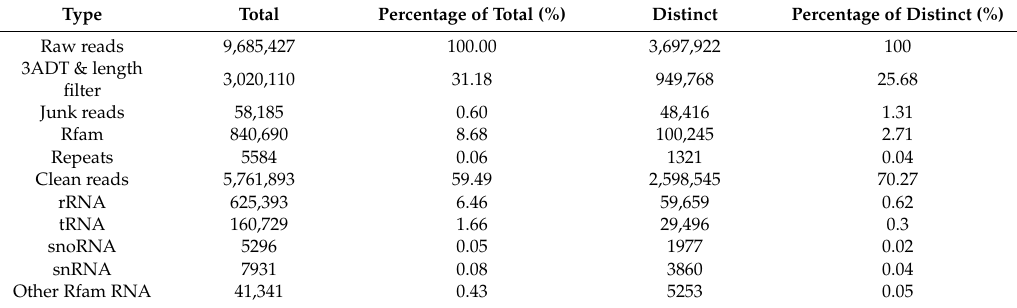
Table 1. Statistical summary of the data that were generated by high-throughput small RNA sequencing in A. membranaceus .